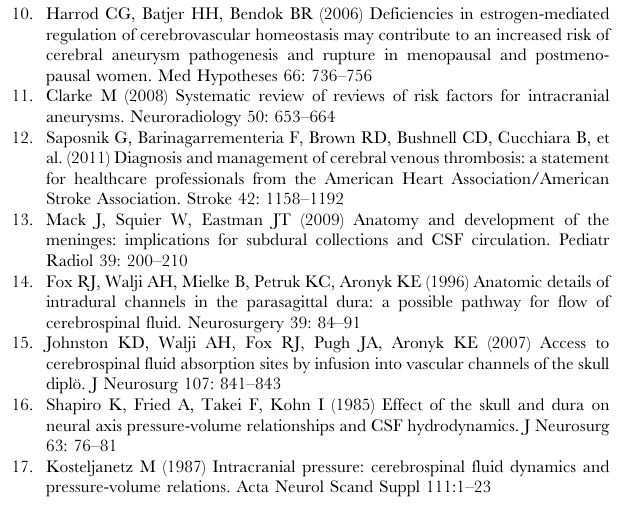
Table S1 Human Growth Factor Antibody Array I Map. Table S2 Abbreviations Used in Human Growth Factor Antibody Array I